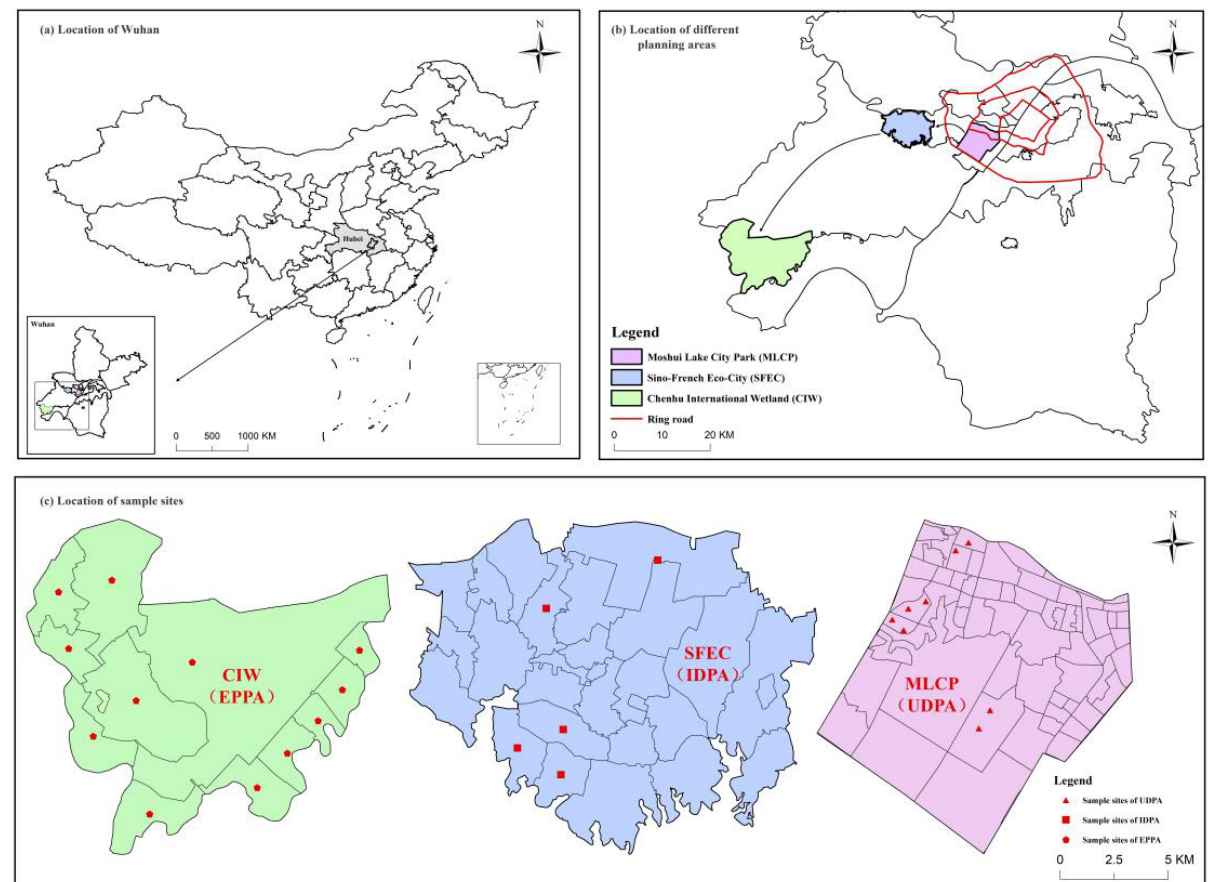
Figure 2. Location of the study area. The three survey sites of our study are marked as MLCP, SFEC, and CIW, respectively, by the authors, and represent three different planning areas, viz. urban development planning area (UDPA), industrial development planning area (IDPA) and ecological protection planning area